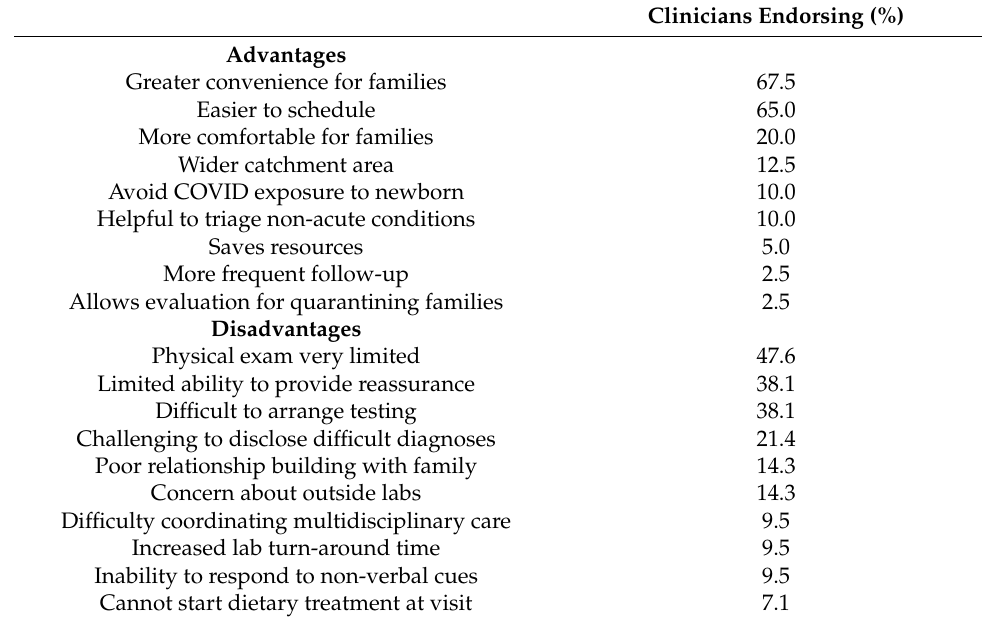
Table 2. Clinician perceptions of telehealth for NBS during the COVID-19 pandemic.